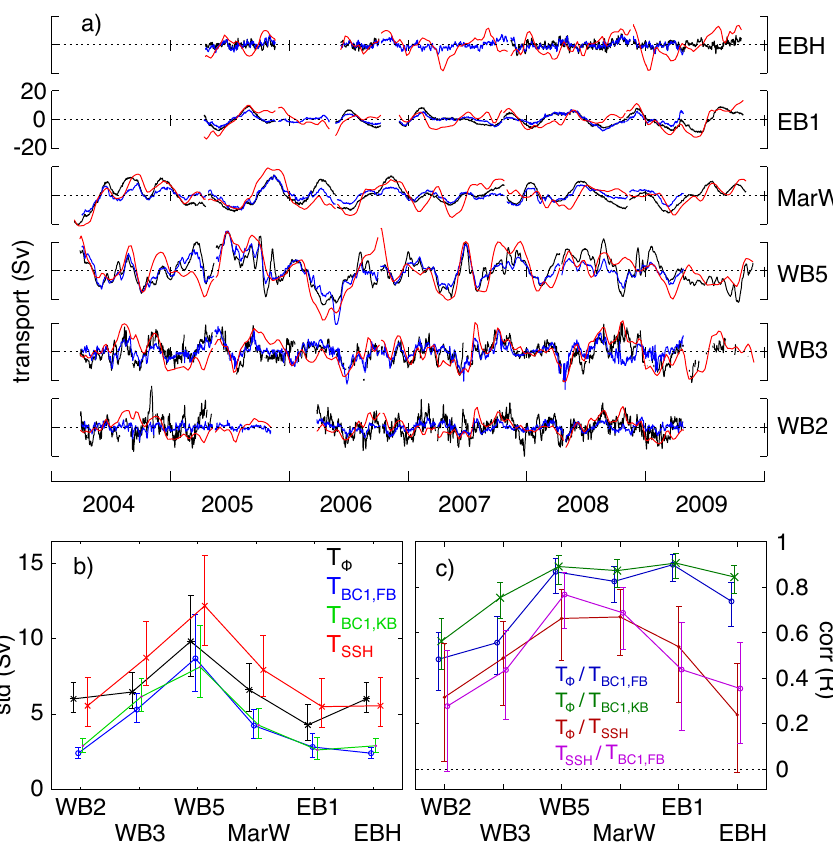
Fig. 8. Local transport calculations. (a) Time series of local transport for the original geopotential anomaly ( T 8 , black), the flat-bottomed BC1-reconstructed mode fit ( T BC1,FB , blue), and the SSH-reconstructed signal ( T SSH , red). Stations are listed from the western boundary at the bottom to the eastern boundary at the top. (b) Standard deviation of T 8 (black), T BC1,FB (blue), T SSH (red), and transport from the KB BC1-reconstruction T BC1,KB (green). (c) Correlations ( R ) between quantities shown earlier: T 8 and T BC1,FB (blue), T 8 and T BC1,KB (green), T 8 and T SSH (red), and T SSH and T BC1,FB (purple). Prior to calculating the correlations, T 8 , T BC1,FB , and T BC1,KB are 10-day low-pass filtered. Error bars are calculated with F-statistics for standard deviations and with Fischer z-transforms for correlations, and the degrees of freedom is the length of the time-series divided by the integral time-scale. Correlations between T BC1,FB and T BC1,KB are higher than 0.93 at all